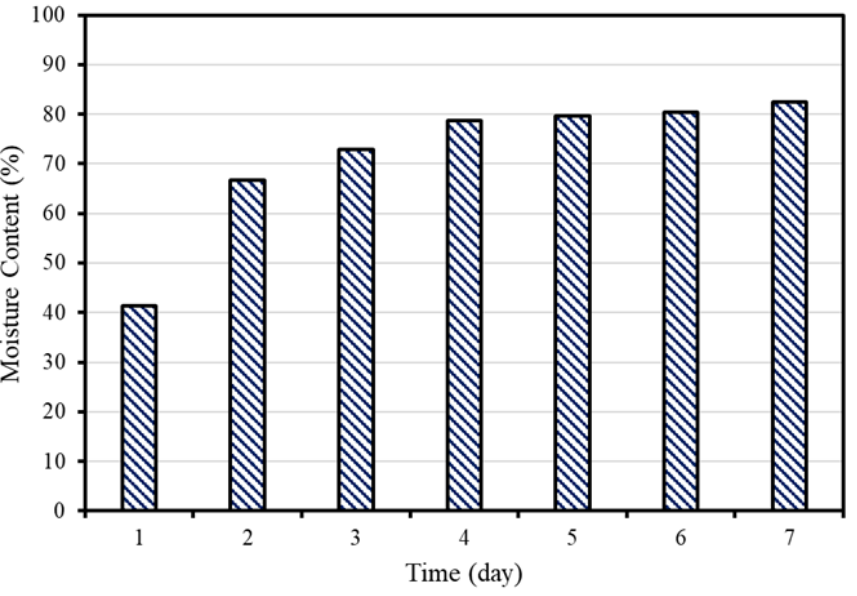
Figure 5. Moisture content of concrete sludge waste (CSW) according to the retention period.